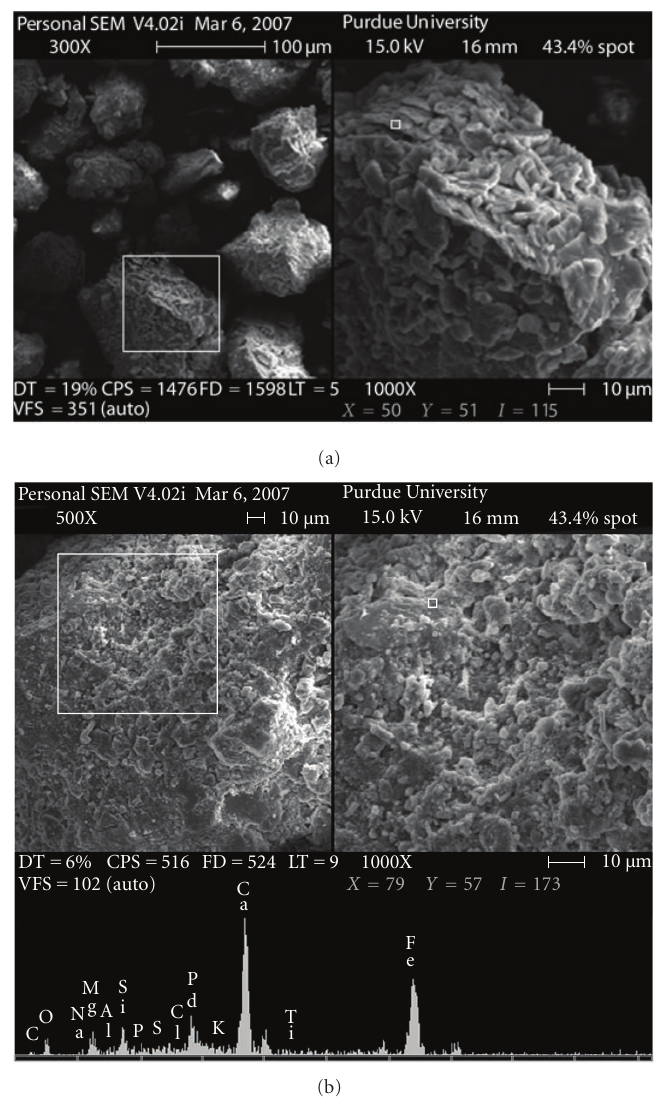
Figure 7: SEM micrographs of BOF slag sample. (a) Particle shape and (b) surface texture and elemental